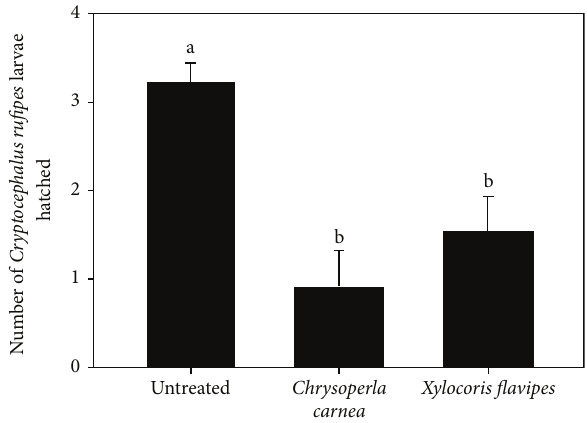
Figure 4: Number of Cryptocephalus rufipes -larvae hatched out of five eggs exposed to Chrysoperla carnea or Xylocoris flavipes , or no predators (untreated). Means followed by the same lowercase letter do not differ significantly at 𝑃 < 0.05 (Dunn’s Method) ( 𝑛 = 11